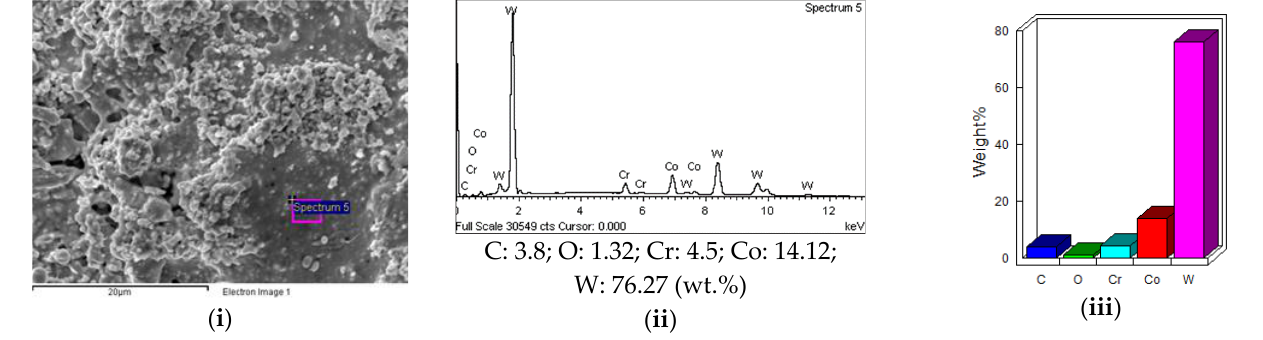
Figure 11. EDS characterization of WC-10Co-4Cr coating. ( i ): microstructure; ( ii ): Element histogram; ( iii ): Quantitative EDS results.